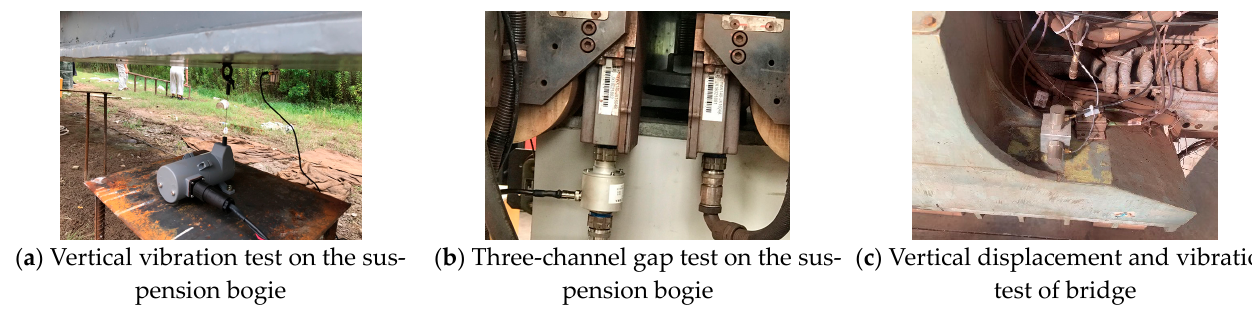
Figure 7. Sensors in the field test.